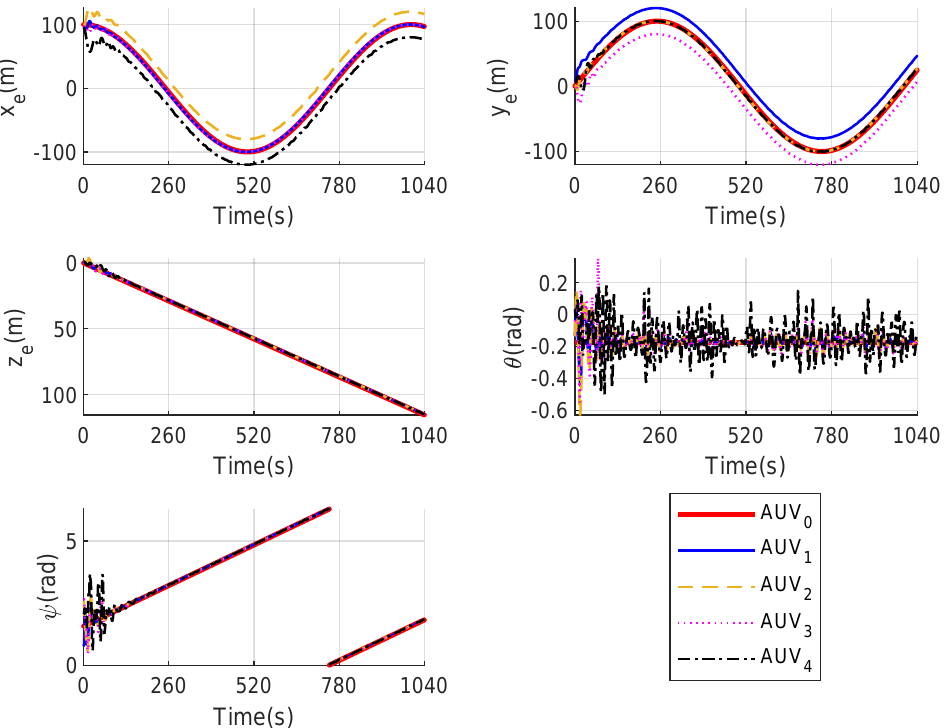
Figure 16. Position states of multi-AUV under alterable communication topology with delay.